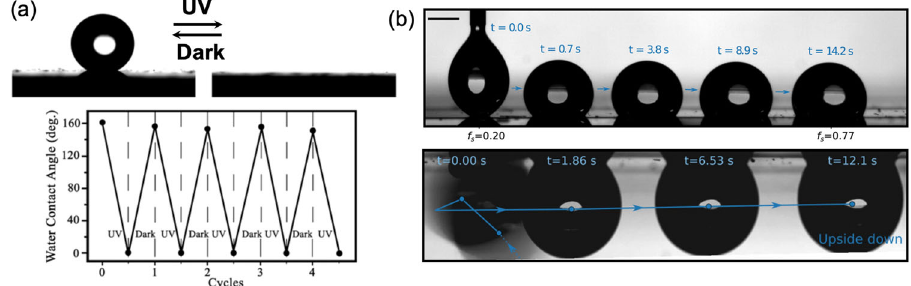
Fig. 6 Strategies for enhanced gas bubble detachment. a Illustration demonstrating the variations of the water contact angle during UV irradiation cycles. Reprinted with permission from Feng, X. et al. Reversible super-hydrophobicity to super-hydrophilicity transition of aligned ZnO nanorod fi lms. J. Am. Chem. Soc. 126 (1), 62 – 63 (2004). Copyright 2004, American Chemical Society 96 . b Illustration of a time lapse imagery of a self-propelled water droplet on a nanopatterned surface (top). A similar illustration from a study of a droplet suspended upside down on a patterned surface (bottom) from Launay et al. (2020) 98